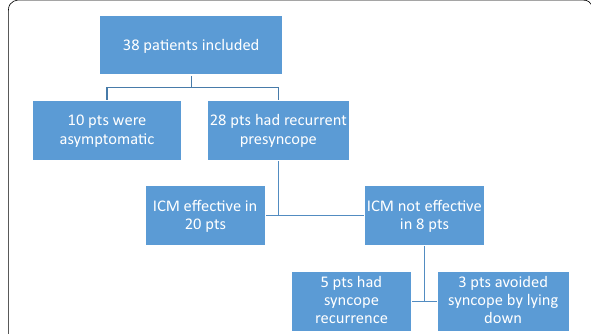
Fig. 5 Clinical follow-up results. HUT head-up tilt test, ICM isometric counter